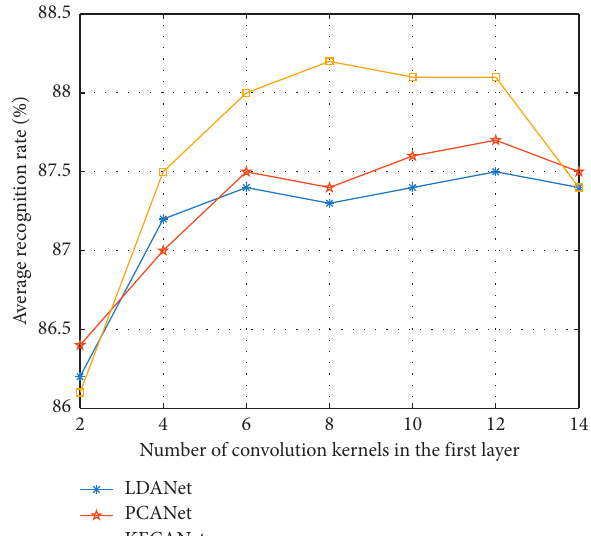
Figure 16: The average recognition rate corresponding to different values of L